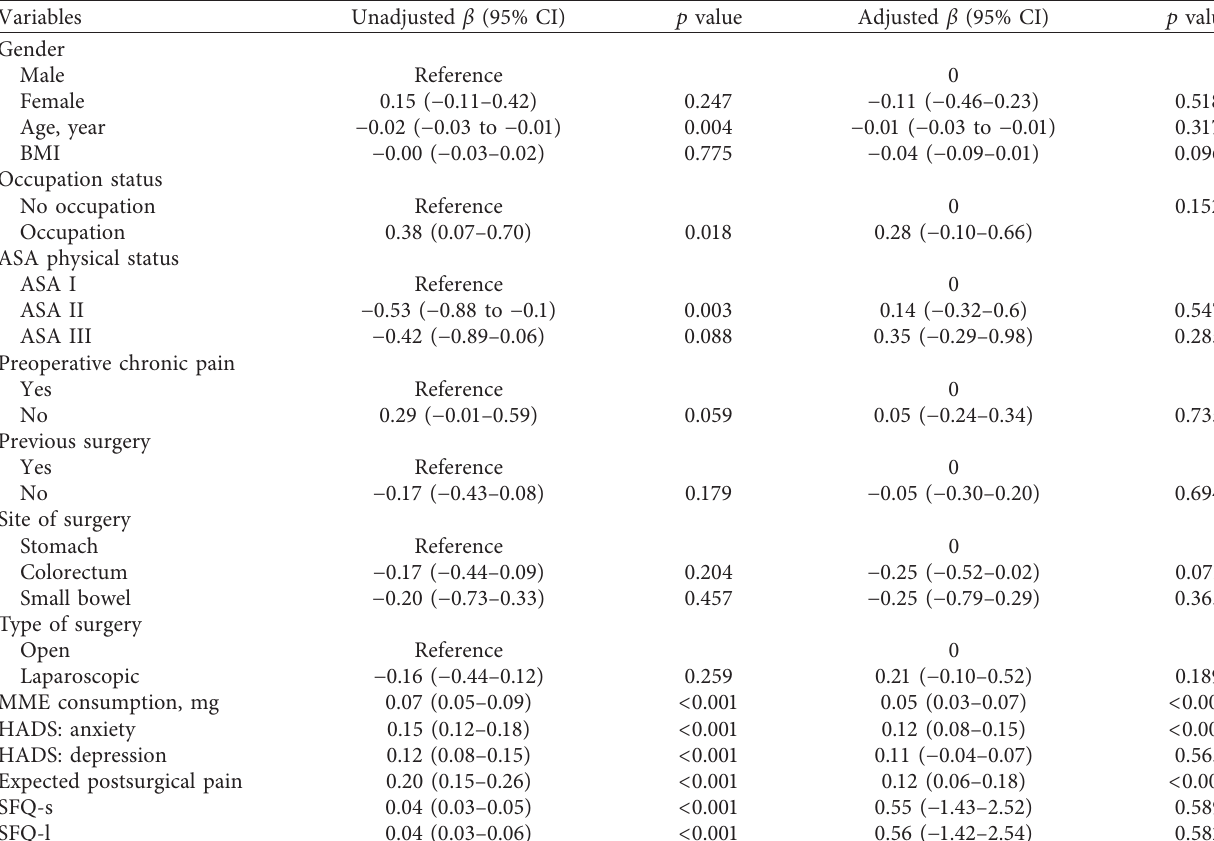
Table 4: Univariate and multivariate analyses of predictors for APSP